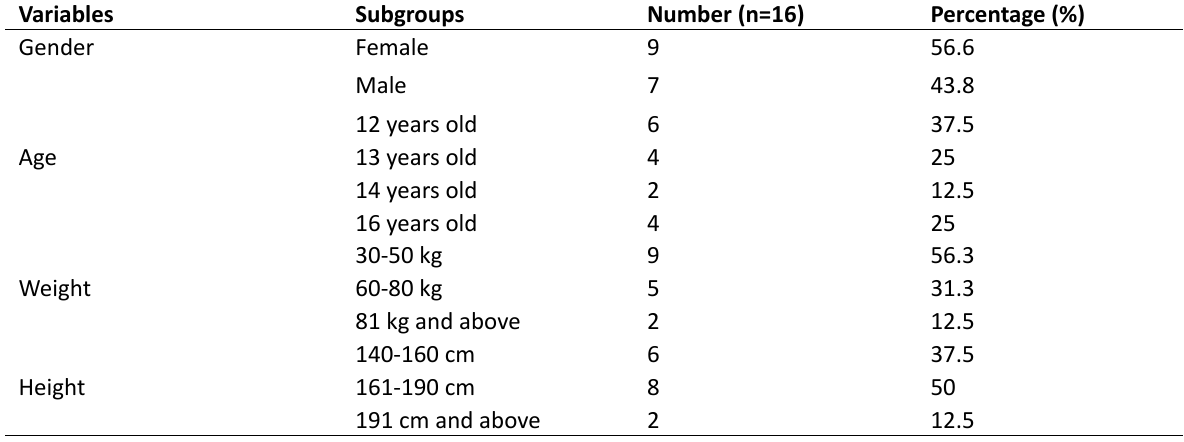
Table 1. Physical Properties of Children with Autism Spectrum Disorder